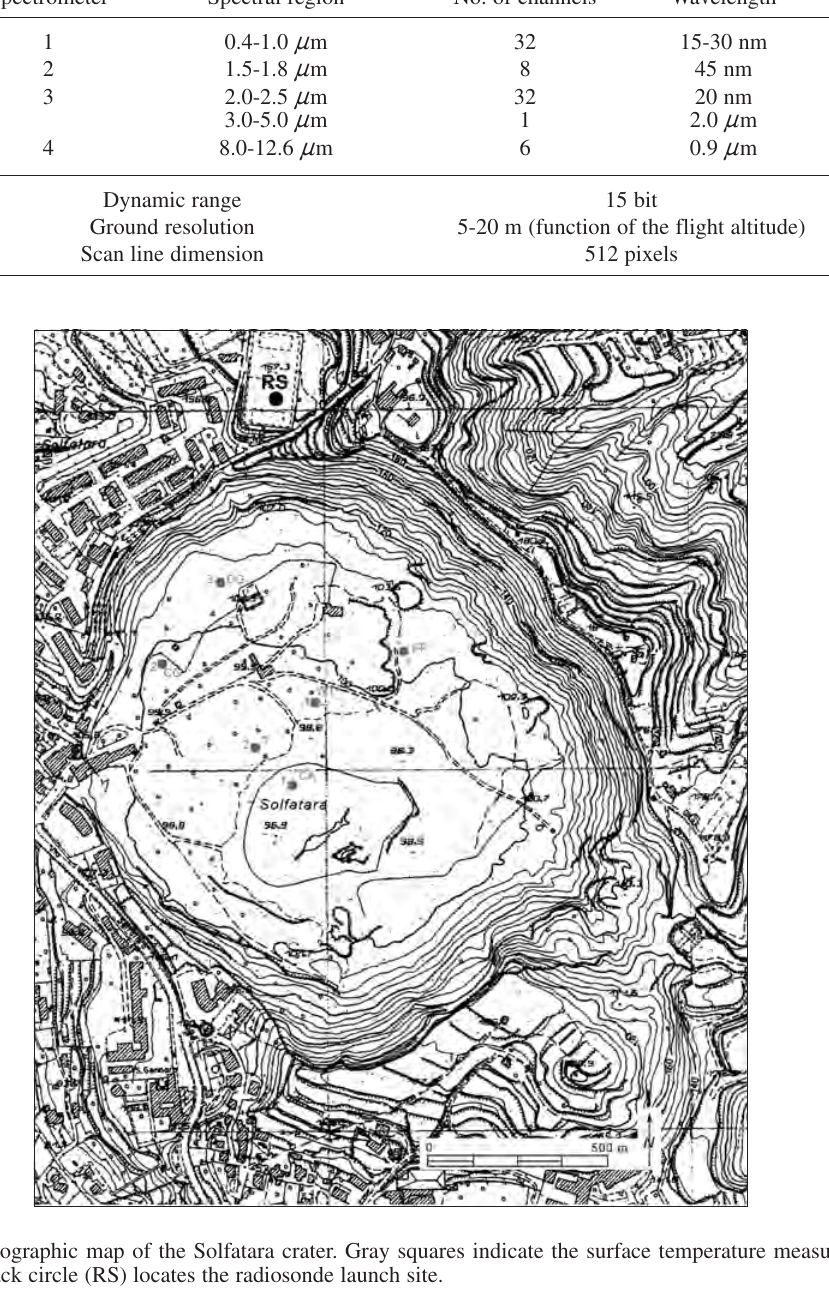
Table I. DAIS 7915 main technical and spectral characteristics. Spectrometer